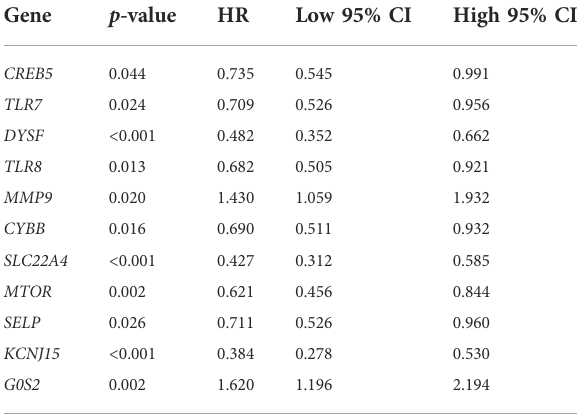
TABLE 1 NET-related genes with signi fi cant prognosis in overall survival analysis. Gene